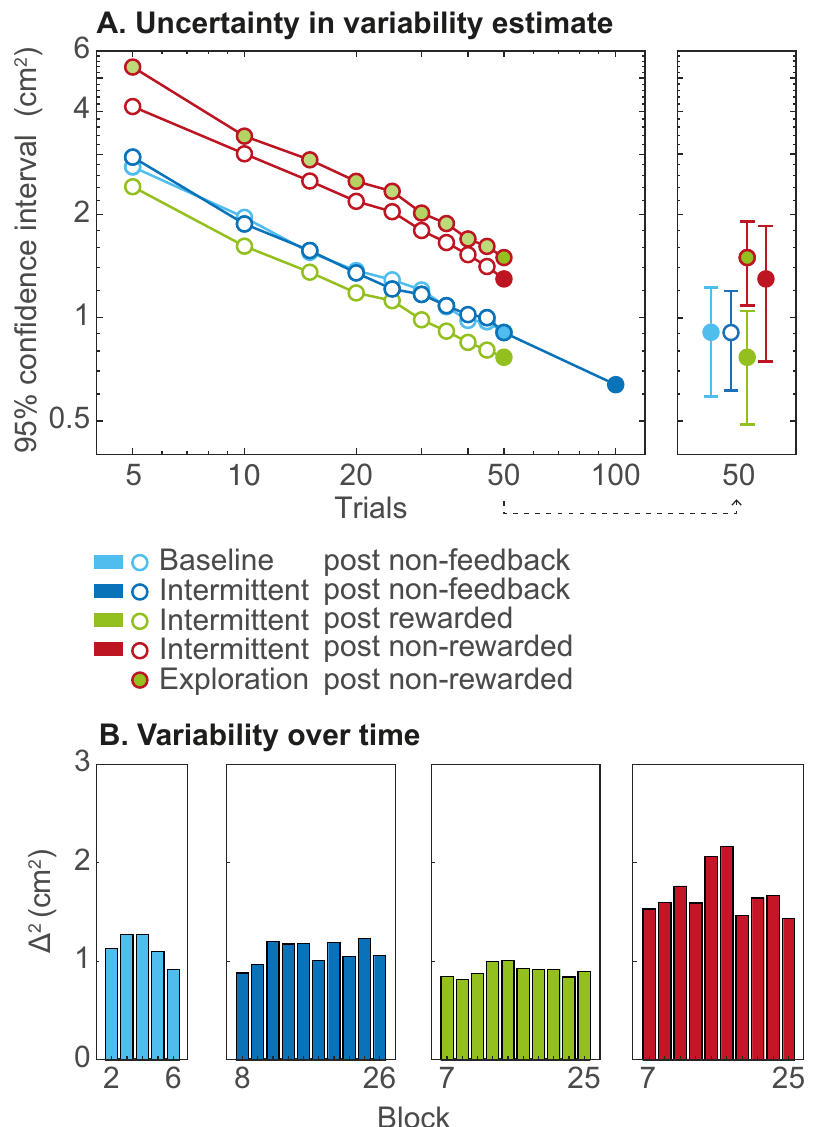
Fig 3. Uncertainty in the estimates of variability. (A) Uncertainty of variability ( Δ 2 ) as a function of number of trials based on which it was estimated (log-log plot). Circles indicate the median across participants. Filled circles correspond to the variability and exploration as presented in Fig 2B and 2C. The right panel provides an indication of variations across participants of this uncertainty: the error bars indicate the interquartile range across participants. (B) Variability estimates ( Δ 2 ) per non-feedback block of 10 trials in the baseline phase and in the intermittent phase, and Δ 2 estimates following rewarded and non-rewarded trials per feedback block in the intermittent phase. Bars indicate the median across